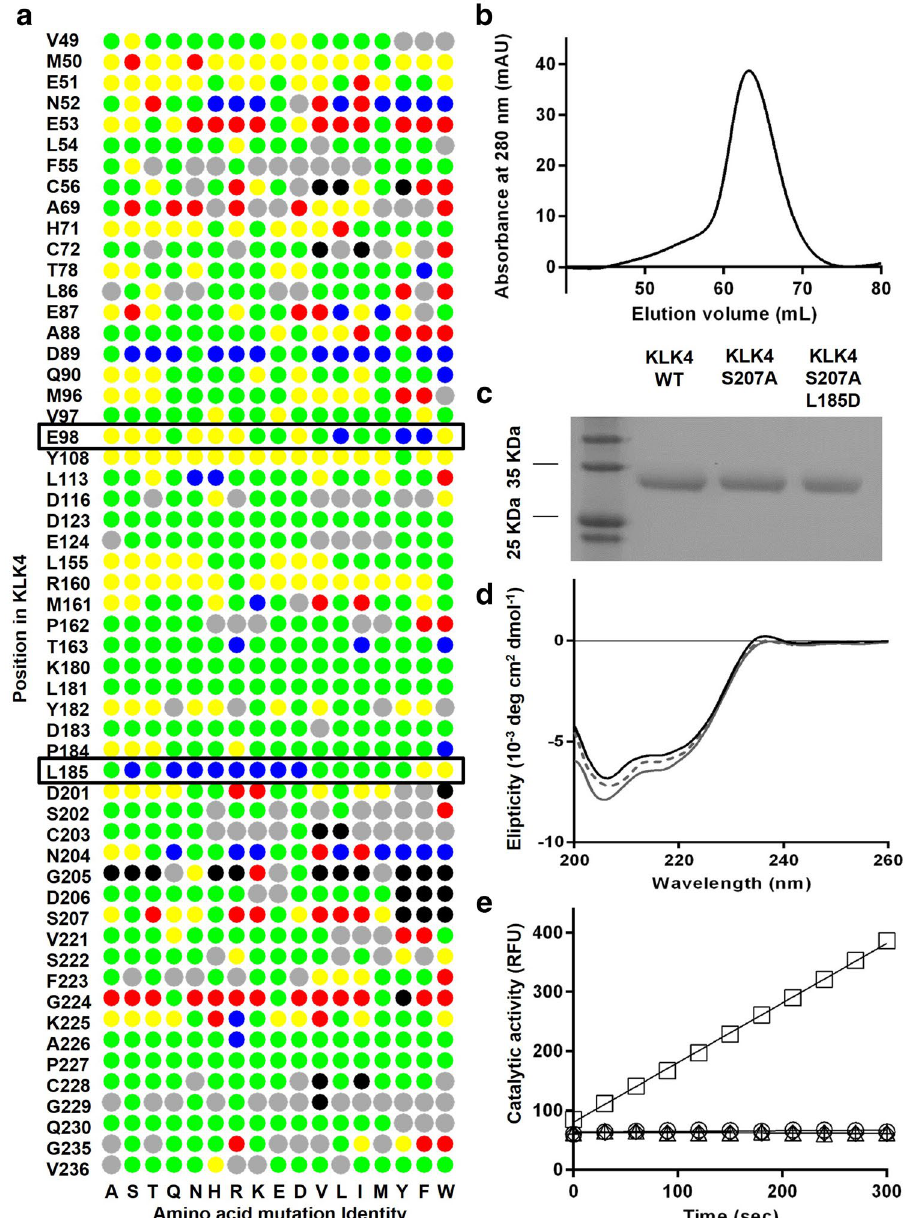
Figure 1. Affinity predictions, purification, and characterization of KLK4 variants. ( a ) The computational binding landscape of KLK4/PAR1 interactions. KLK4 binding interface residues and their identity in the wild- type sequence are shown on the left, and the amino acids to which they were mutated are shown on the bottom. The change in binding free energies conferred by the mutations are color coded according to the following characteristics: blue—stabilizing, green—neutral, yellow—slightly destabilizing, and red—strongly destabilizing. The gray dots represent mutations that destabilize KLK4 S207A . The calculations were performed using the in silico saturation mutagenesis protocol of Sharabi et al. ( b ) A representative size-exclusion chromatography (SEC) UV absorbance signal of pro-KLK4 proteins (shown here for KLK4 WT ) after the Ni–NTA elution purification step. ( c ) SDS-PAGE of KLK4 WT and of KLK4 S207A and KLK4 S207A,L185D as selected purified pro-KLK4 variants. ( d ) CD spectra of KLK4 WT , KLK4 S207A and KLK4 S207A,L185D (10 µM), as indicated with a solid black line, a dashed line and a solid gray line, respectively. ( e ) Catalytic activity of KLK4 WT and the KLK4 variants KLK4 S207A and KLK4 S207A,L185D . A BOC-VPR-AMC fluorescent substrate was added to KLK4 WT ( □ ), KLK4 S207A (Δ), and KLK4 S207A,L185D ( ○ ), all at final a concentration of 625 nM, or to buffer (control, ◊), and the fluorescent signal upon substrate cleavage was